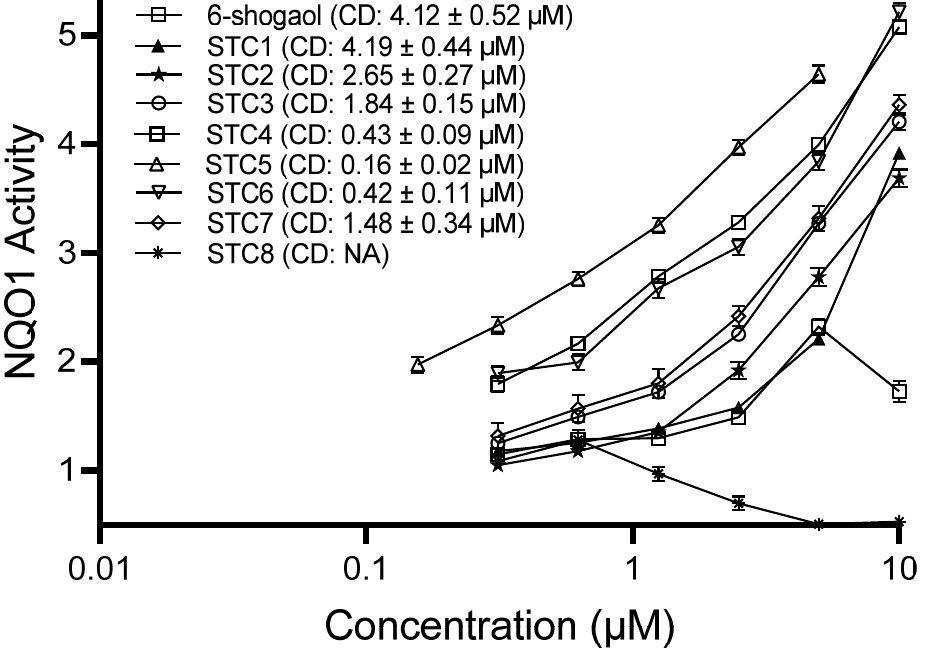
Figure 3. Dose-response curve of 6-shogaol and STCs on NQO1 induction in Hepa-1c1c7 cells. The qPCR studies were carried out to determine the effect of 6-Shogoal and STCs (at 1 µ M) on the expression of the NRF2 gene and its downstream representative eleven antioxidant genes (HMOX1, NQO1, GCLC, GCLM, TXNRD1, PRDX1, GPX2, GSTP1, GSTM2, GSTA1, and G6PDX). The gene expression results are shown in Figure 4. All the compounds (6-shogaol and STCs) have upregulated the expression of all the genes (NRF2 and its associated antioxidant genes). STC5 at 1 µ M showed the maximum activity. STC1’s activity is almost similar to that of 6-shogaol. STC8 showed lower activity than 6-shogaol. The compounds STC4 and STC6 showed similar activity. The foldchange (compared to control) in the upregulation of genes expression by STC5 compared to 6-shogaol (fold change values are shown in parenthesis) are as follows: (1) NRF2, 3.21 ± 0.08 (1.26 ±